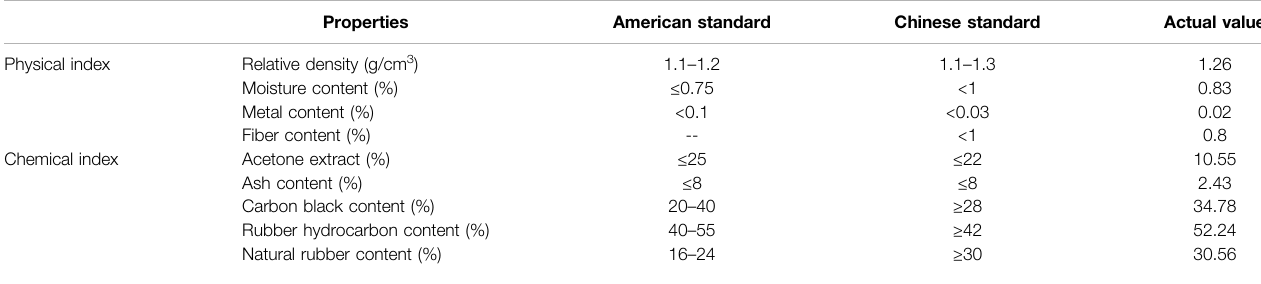
TABLE 1 | Properties of waste rubber powder